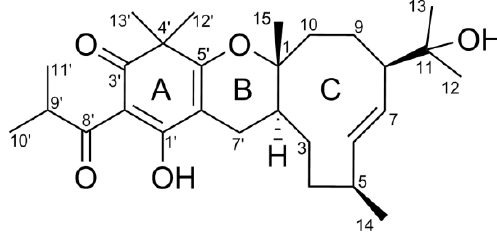
Figure 1. Structure of compound 1 .